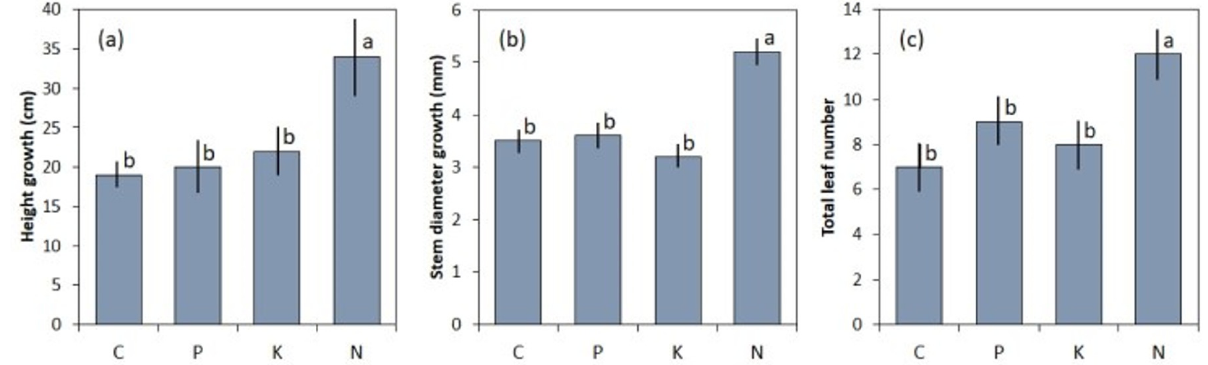
Figure 1. Growth traits of Serianthes kanehirae plants influenced by phosphorus (P), potassium (K), or nitrogen (N) fertilization in relation to control (C) plants. ( a ) Height; ( b ) stem diameter; ( c ) leaf number. Means ± standard error, n = 6. Bars with same letters are not different. Table 1. The influence of N, P, or K fertilization on nutrient concentrations of Serianthes kanehirae leaves. C = control; P = phosphorus fertilization; K = potassium fertilization; N = nitrogen fertiliza- tion. Mean ± SE, n = 6.